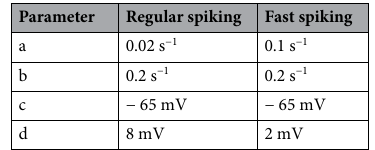
Table 1. Parameter values of the Izhikevich neuron